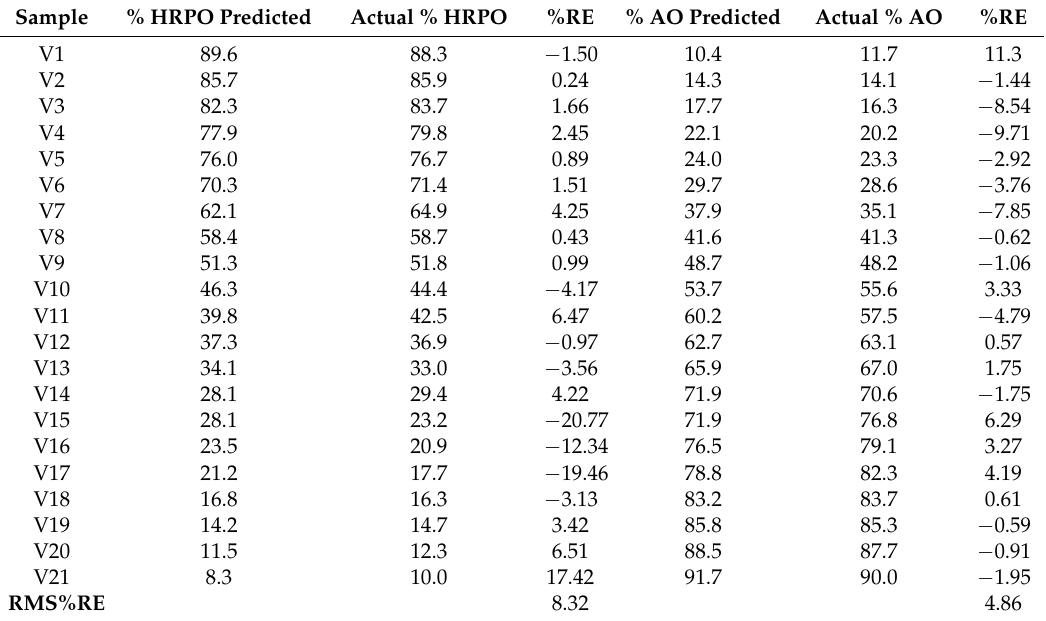
Table 4. Validation conducted for highly refined peanut oil (HRPO) adulterated with almond oil (AO).